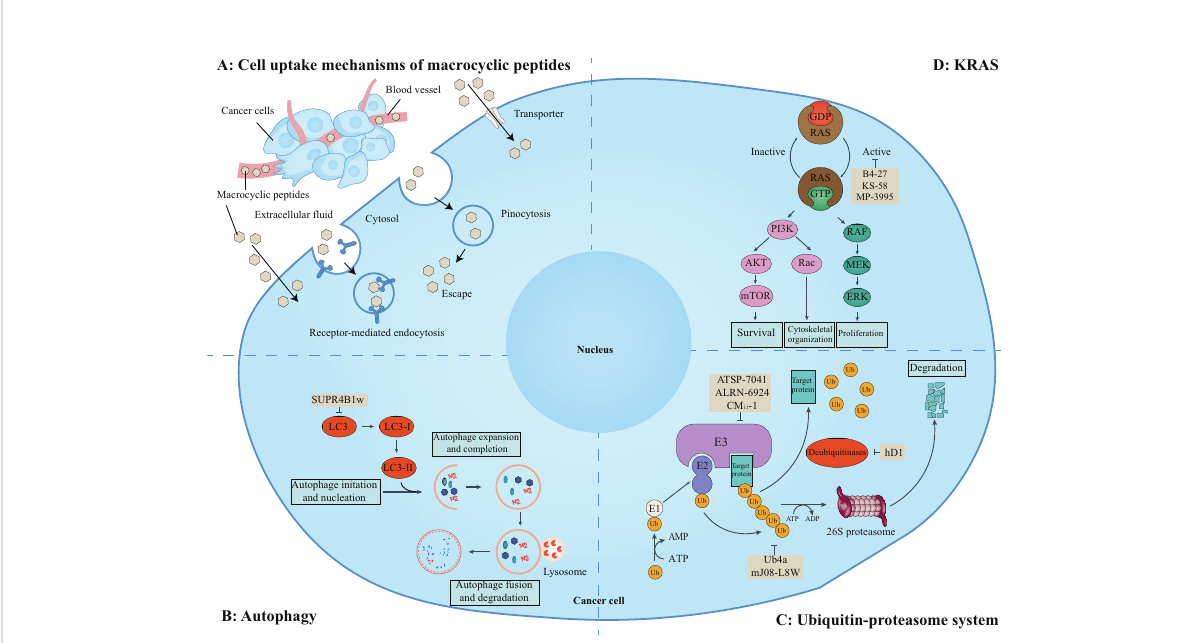
FIGURE 6 Macrocyclic peptides targeting intracellular protein-protein interactions. This schematic shows the cell uptake mechanisms of macrocyclic peptides, intracellular proteins, related signaling pathways, and cellular functions. (A) Overview of cell uptake mechanisms of macrocyclic peptides. Some macrocyclic peptides can cross the cell membrane in a passive way as small-molecule drugs. Other macrocyclic peptides may cross the cell membrane via receptor-mediated endocytosis, pinocytosis and pinosomal escape, and active transportation. (B) Macrocyclic peptides can target microtubule-associate protein light chain (LC)3 which is essential for the maturation of the autophagosome. (C) Macrocyclic peptides can target the ubiquitin-proteasome system which regulates many aspects of cell biology. (D) Macrocyclic peptides can target KRAS mutations which are important for cell survival, proliferation, and cytoskeletal